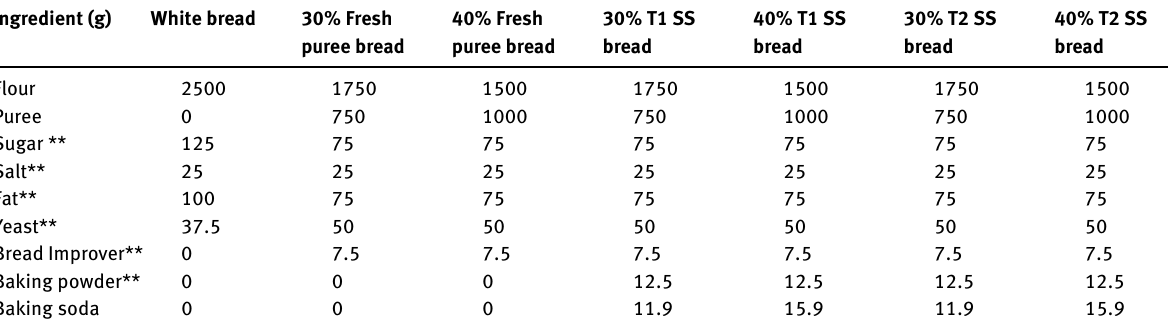
Table 1: Formulation for White, Fresh OFSP and Shelf-Storable OFSP Puree Breads Ingredient